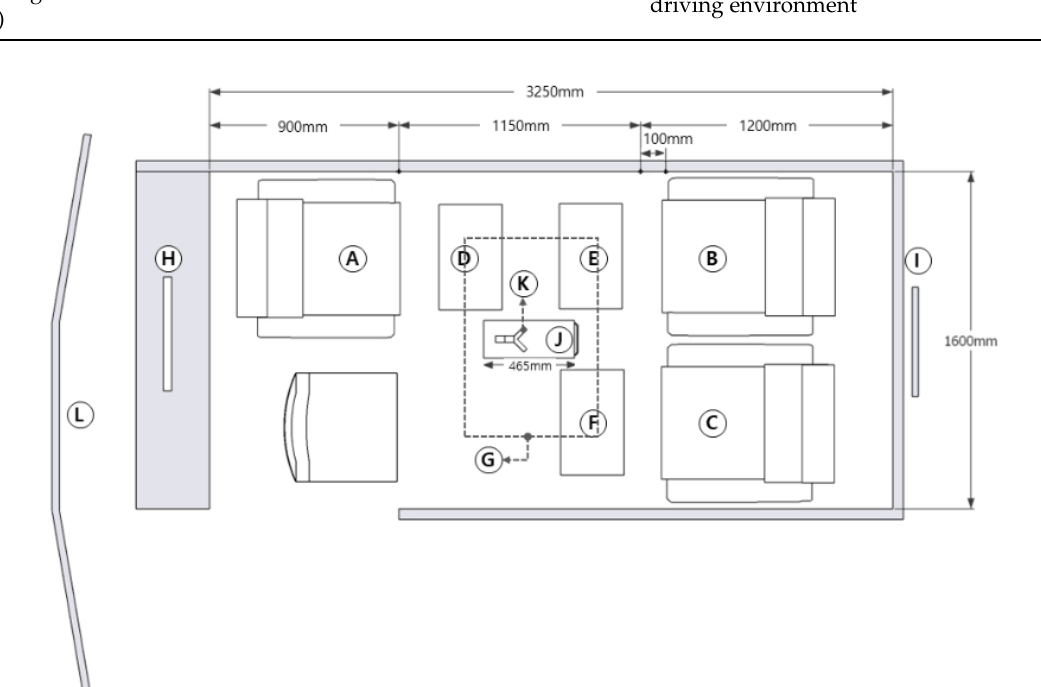
Figure 1. Layout of experiment environment of a fully autonomous vehicle.